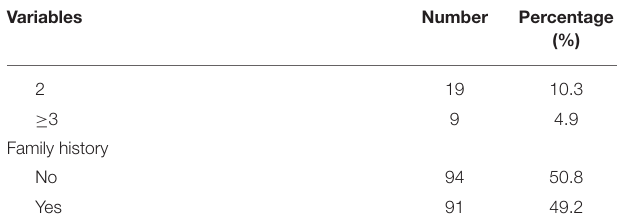
TABLE 1 | Socio-demographic and clinical characteristics of the participants ( N =